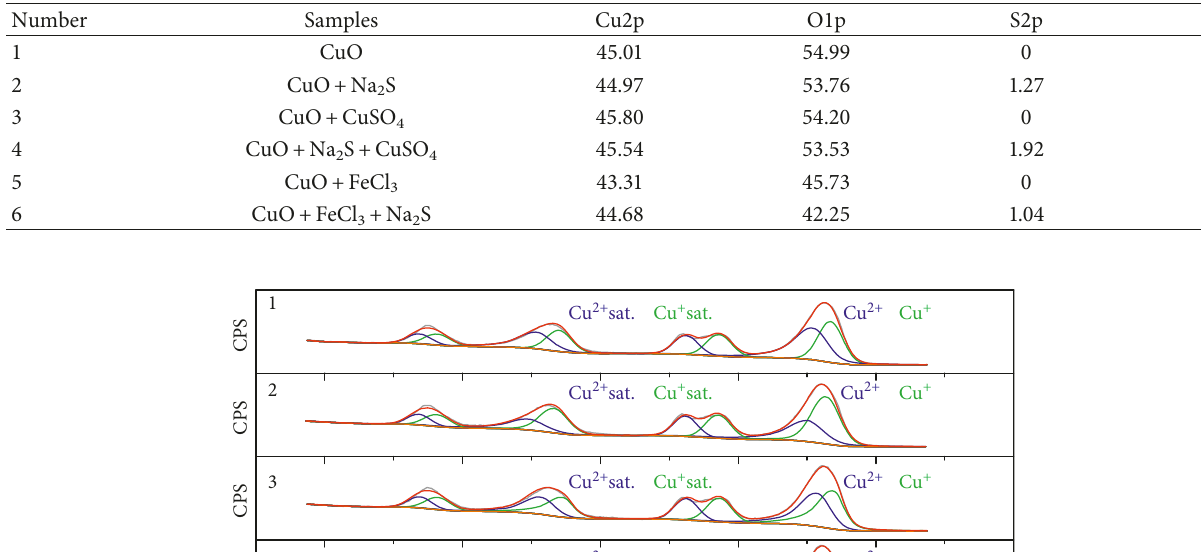
Table 5: Atomic percentage (%) of elements on CuO surface.